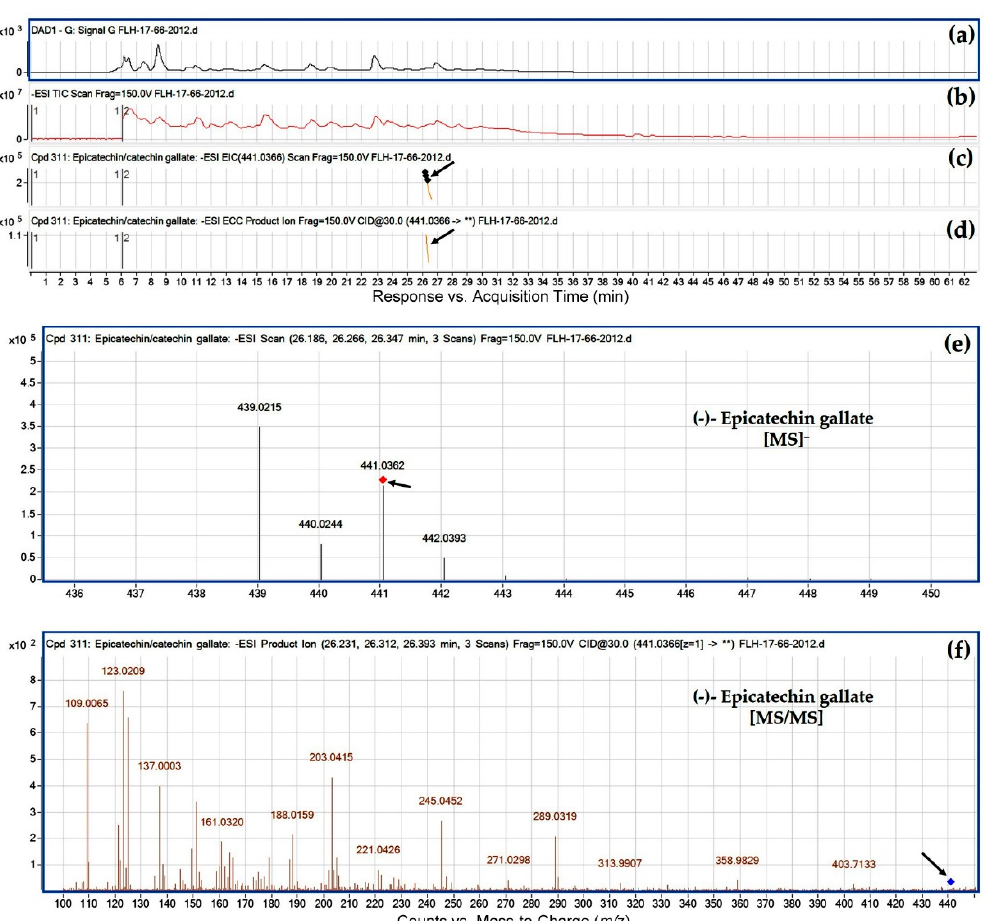
Figure 8. Extracted ion chromatogram (EIC) of primary mass spectrum (MS1) and m / z features of secondary ion fragments (MS2) derived from LC-MC/MS annotate this peak to be ( − )-epicatechin gallate (MW, 442.37). ( a ) Chromatogram of FLH 17-66 extract (2012) recorded at 280 nm; ( b ) total ion chromatogram of FLH 17-66 extract (2012); ( c ) EIC of primary ion 441.0366 [M − H]¯; ( d ) enhanced charge capacity (ECC) ion product for m / z 441.0366; ( e ) a MS profile showing an extracted m / z value, 441.0362; and ( f ) fragments from collision-induced dissociation (CID) of m / z 441.0362 showing m / z 109.0065, 123.0209, 137.0003, 151.0112, 179.0064, 245.0452, 271.0298, 289.0319, 313.9907, 331.9910, and 358.9829 (Table